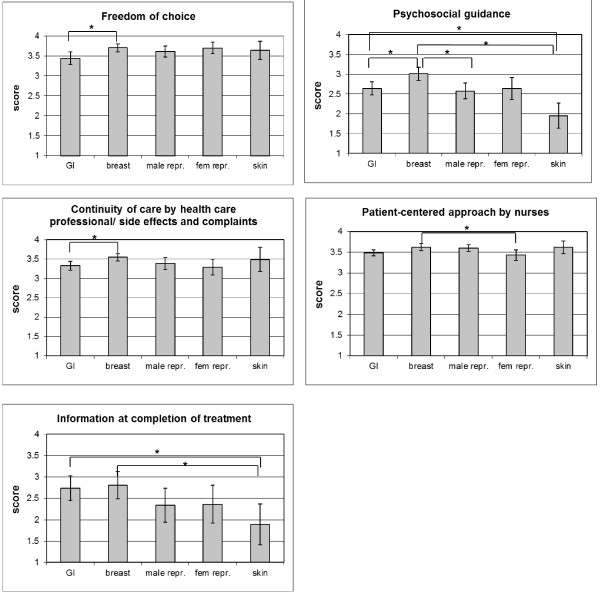
Average scale score and 95% confidence intervals for scales with statistically significant differences in average score between tumour types (ANOVA p<0.05). Differences in average scale scores are reported for the five most commonly reported tumour types. Calculations are based on 205 tumours of the digestive tract, 171 breast tumours, 153 tumours of the male reproductive organs, 73 tumours of the female reproductive organs and 70 tumours of the skin.